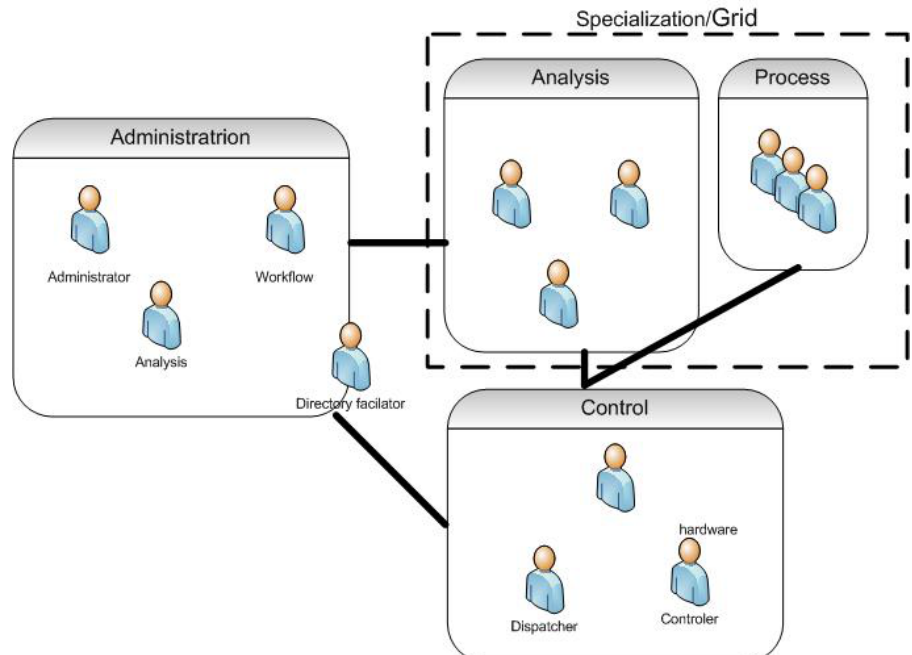
Figure 1: Architecture for system coordination and control